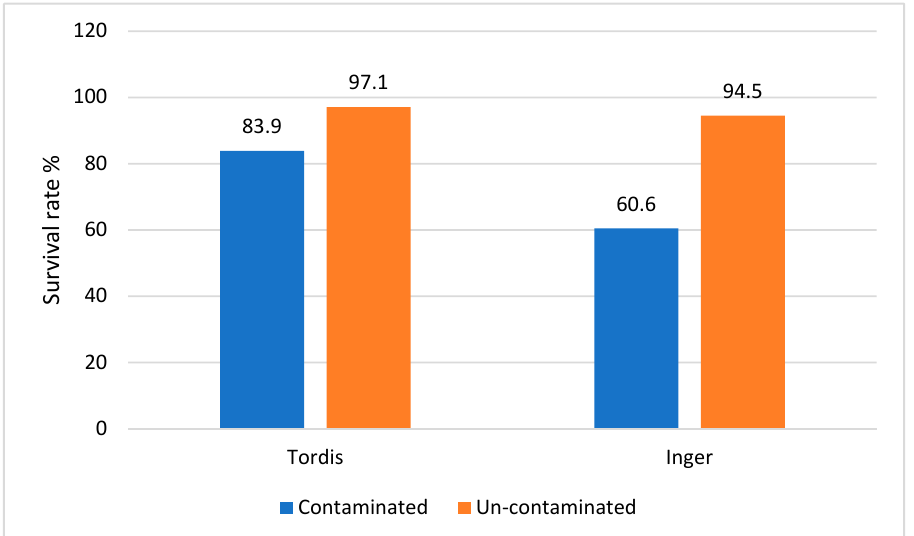
Figure 5. Survival rate of the two clones in contaminated and uncontaminated soil.